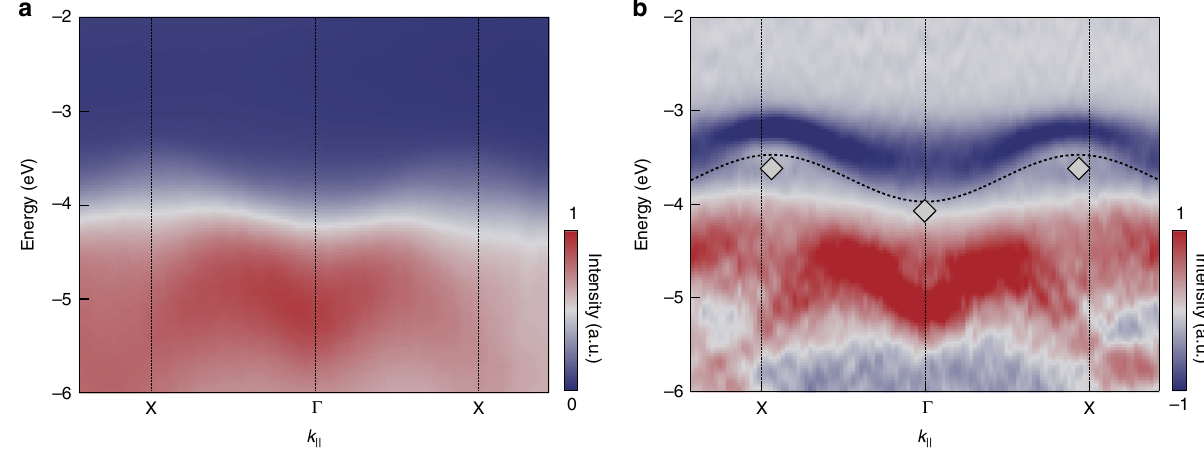
Fig. 3 ARPES data of a single crystal of anatase TiO 2 . a ARPES energy vs. momentum intensity map for a crystal doped with an excess electron density n = 2 × 10 19 cm − 3 at 20 K. b Second derivative ARPES data of the electronic structure at the top of the VB between Γ and X. Dashed blue lines are added as a guide to the eye. The spectrum is referenced to the bottom of the CB at Γ . The intensity is indicated by a linear colour scale, as displayed in the colour